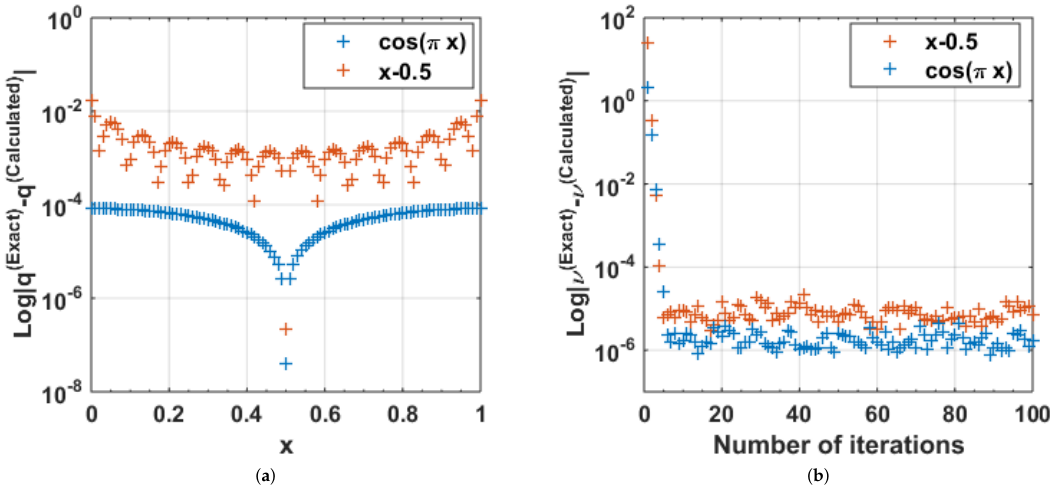
Figure 6. ( a ) Log absolute error in the reconstructed q ; and ( b ) log absolute error sum of the difference of the eigenvalue sequences { ˆ ν n } and { ν and q ( x ) = x − 0.5 (red).